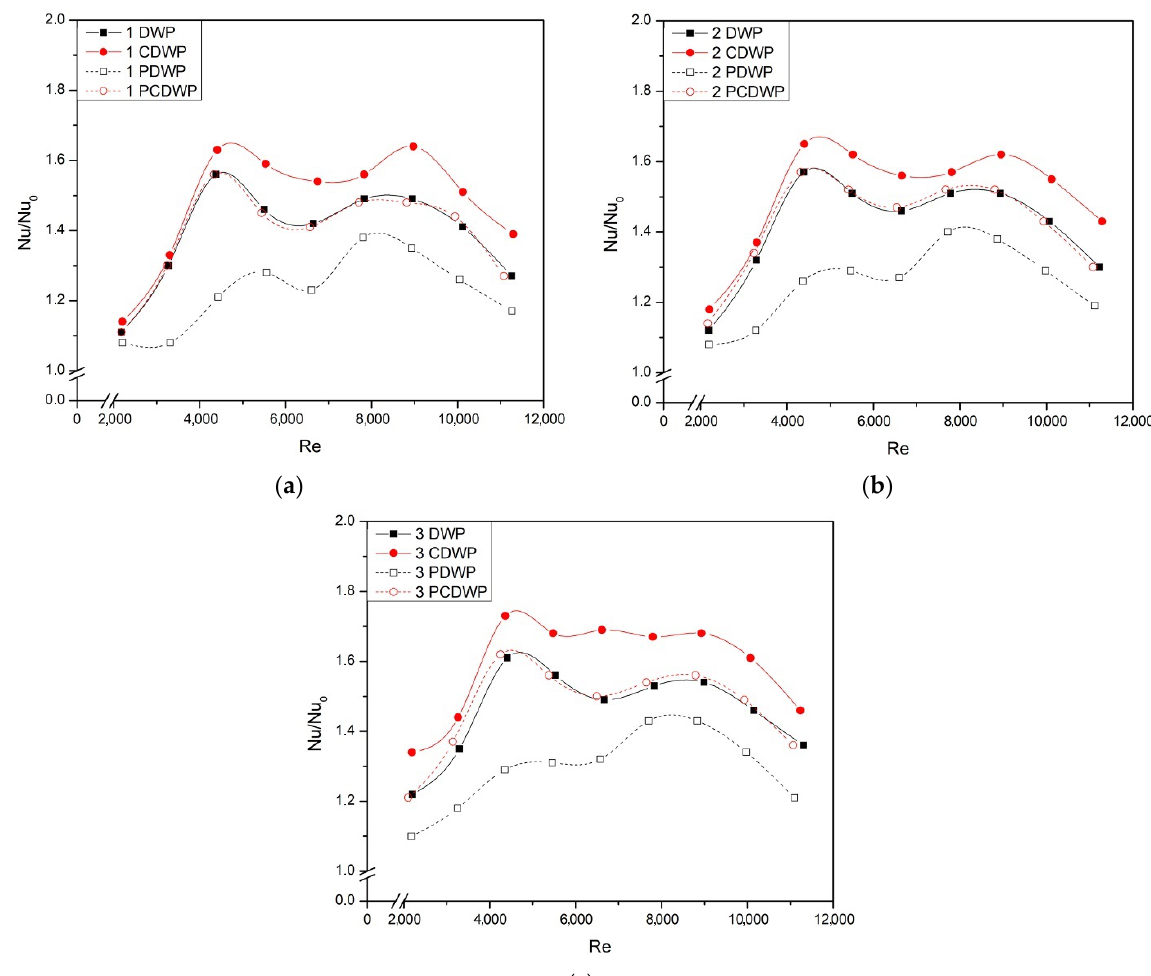
Figure 4. Nu/Nu 0 on the use of VGs with/without holes on the Reynolds number and the number of pairs of VGs. ( a ) One pair of VG, ( b ) Two pairs of VG, and ( c ) Three pairs of VG.